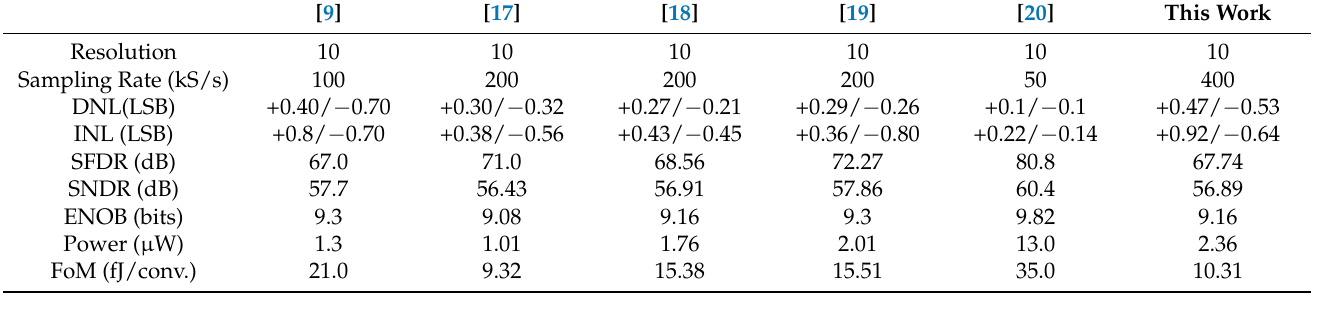
Figure 15. Measured DNL and INL.